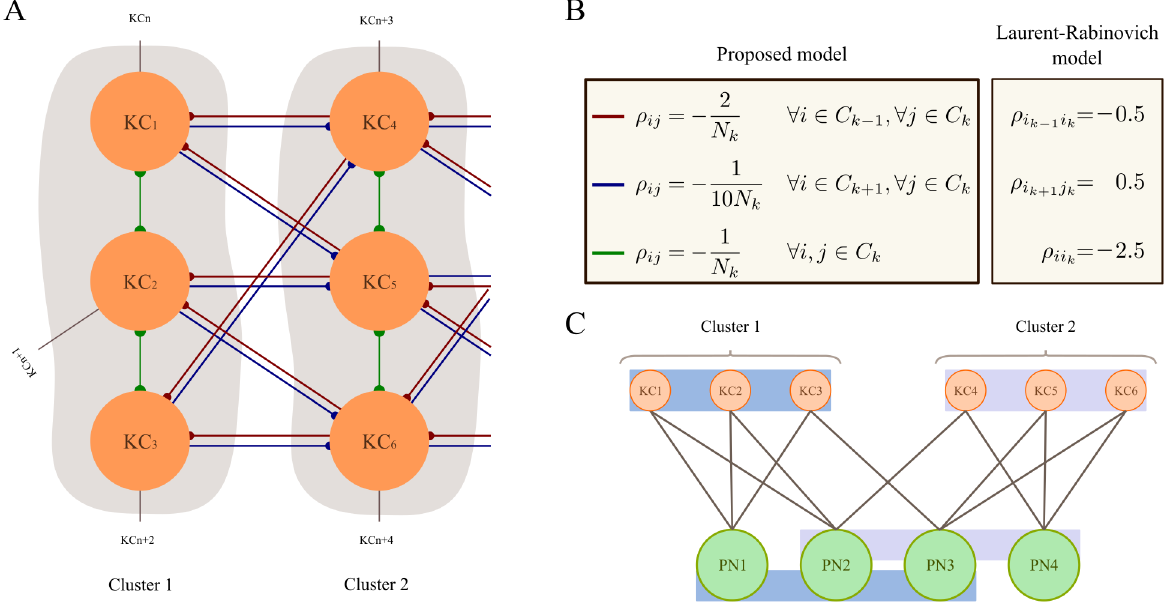
Fig 1. Connectivity among KCs and PNs. (A) Clusters of KCs and their connectivity. The connections shown here are the low-inhibition connections (blue) and high-inhibition (red) between specific KCs and the medium inhibition between members of a cluster (green). The high-inhibition all-to-all connections are not depicted. Each neuron is connected (as an example) to three other neurons outside of its cluster. A line with a single dot at the end means that the connection is one-way only. The neurons in one cluster connect to each other and to elements outside the cluster. Those neurons that receive input from more than one KC in a cluster form the cluster to be activated next. Each KC could connect with a neuron that is not part of the next cluster; these connections are labeled KCn, KCn+1, etc. and arise because KCs can belong to other clusters as well. (B) Conditions for the connectivity matrix in the proposed model and in the [11] model. In the proposed model, all components of the connectivity matrix ρ are negative (inhibition), whereas the [11] model uses both inhibition and excitation. C k is the k-th cluster, i.e. i (cid:1) C k for all neurons in cluster k. (C) Example of connections between KCs and PNs. KCs work as coincidence detectors, being activated only when both the PNs they are connected to are activated. Shown, a population of 6 KCs divided in two clusters. Four PNs are connected to the KCs so that each KC sees half of the PN population. When PNs 1, 2 and 3 are active, cluster 1 is activated. Cluster 2 is activated with PNs 2, 3 and